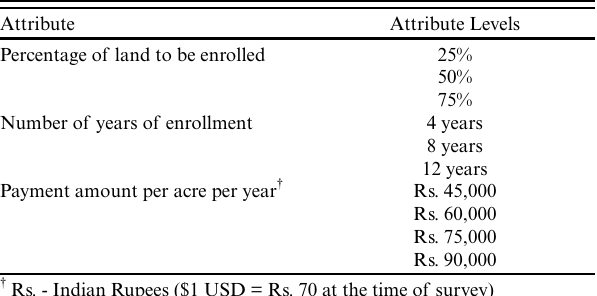
Table 1. Attributes and attribute levels for the stated preference choice experiment